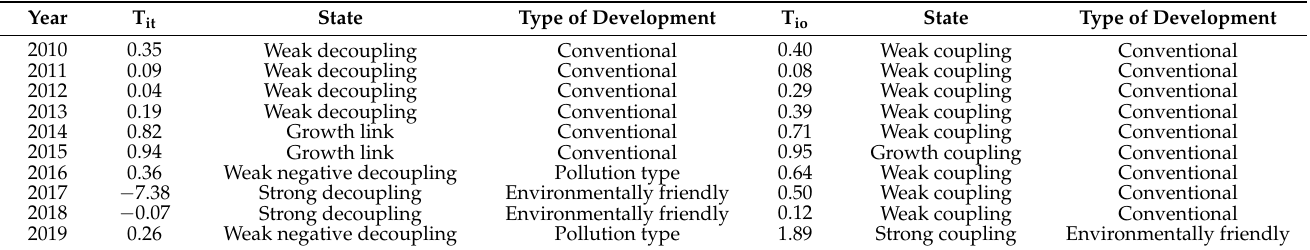
Table 14. Decoupling and coupling relationship analysis table of nine coastal provinces from 2010 to